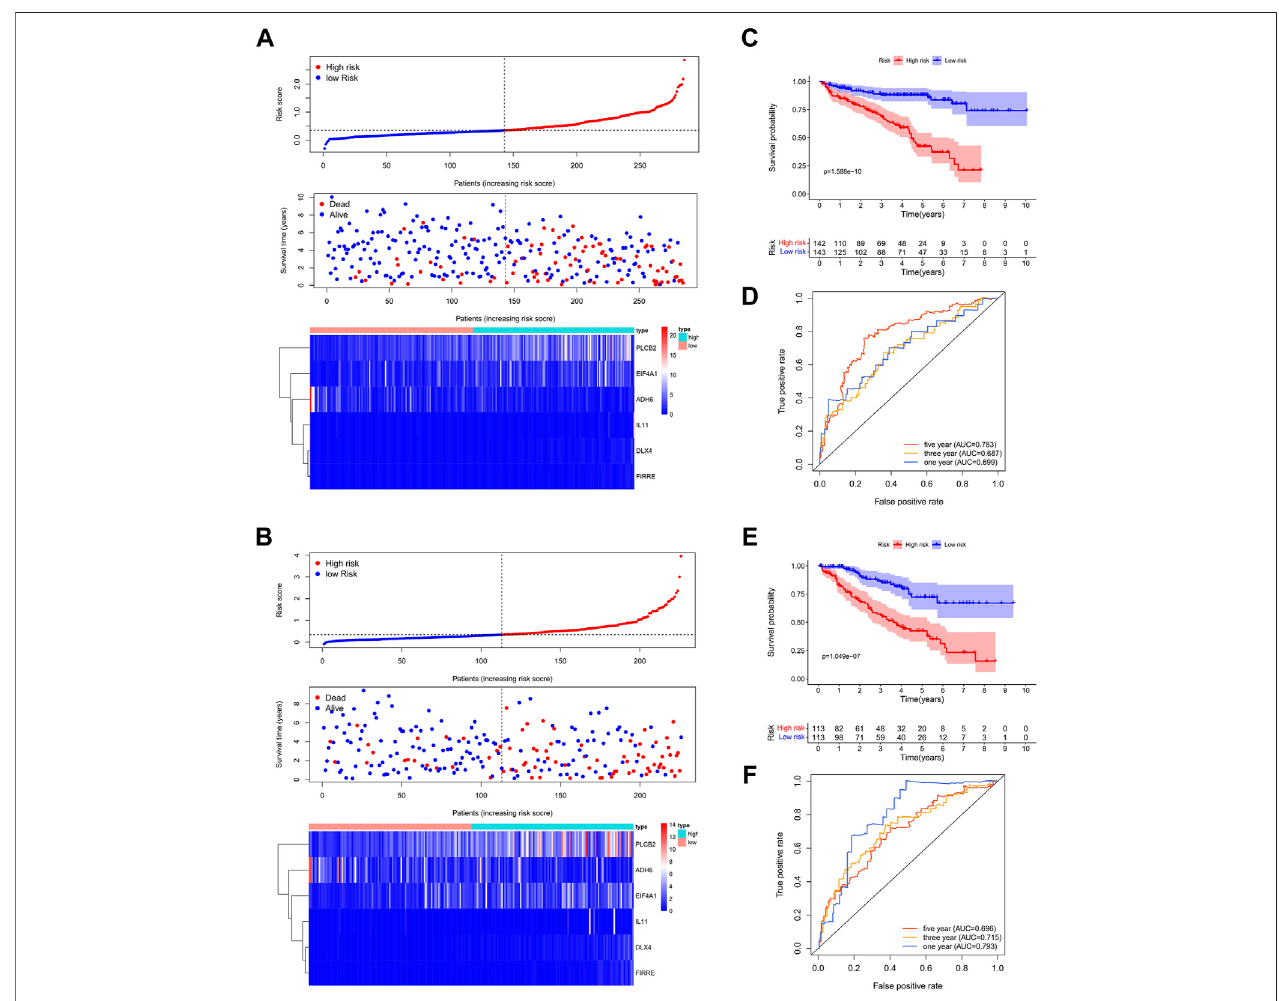
FIGURE 3 | Construction and validation of prognostic signatures of butyrate-metabolism-related genes. Distribution of risk score, OS, and OS status and the heatmap of the six prognostic butyrate-metabolism-related genes in TCGA training cohort (A) and TCGA validation cohort (B) . Kaplan – Meier curves of OS for patients withccRCC basedontheriskscoreinTCGAtraining cohort (C) and TCGAvalidationcohort. (E) 1-,3-,and5-yearROCcurvesand AUCvaluesinTCGAtrainingcohort (D) and TCGA validation cohort (F) .